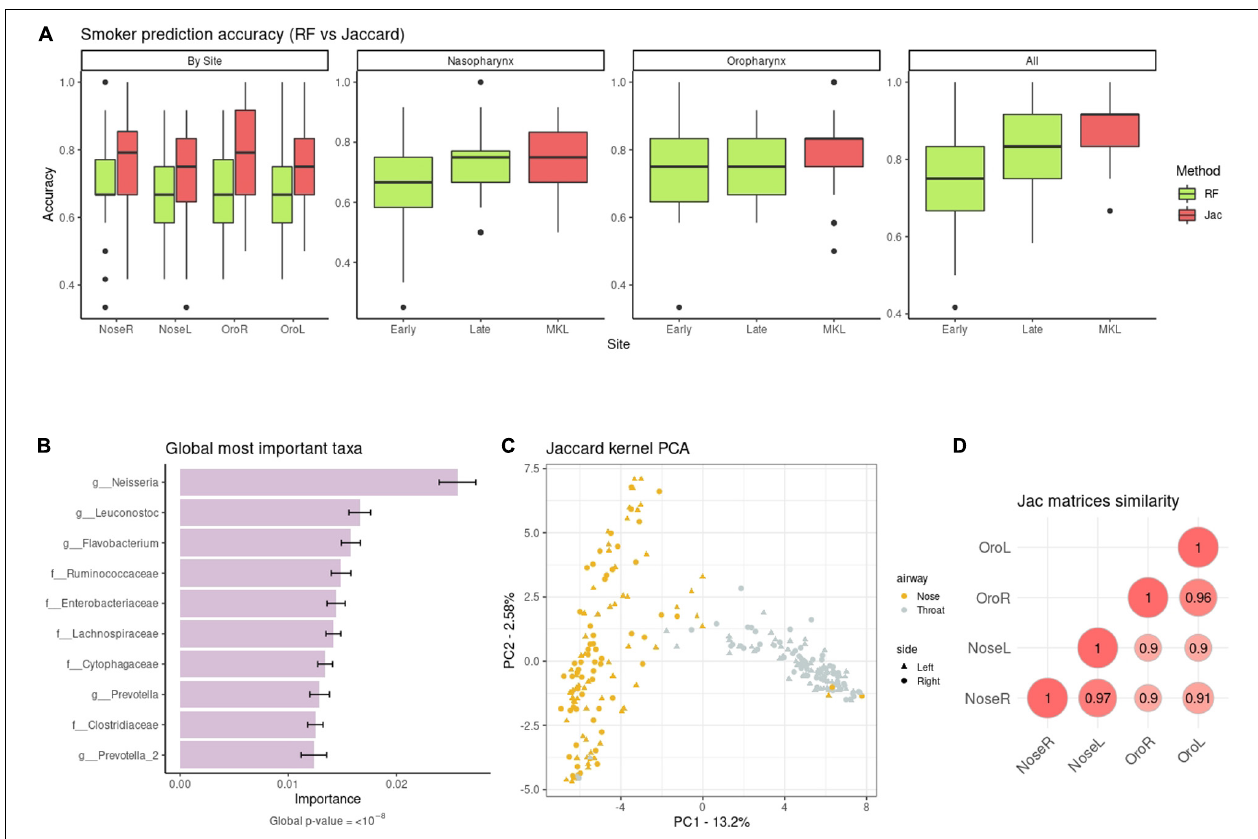
FIGURE 3 | (A) Non-smoker/smoker accuracies from taxonomic data: RF (green) vs. the quantitative Jaccard kernel (red). NoseL, NoseR, OroL, and OroR models are obtained from single datasets, the Nasopharynx and Oropharynx panels contain the information from the right and left sides, and All the combination of the four datasets. Early and Late refer to the early integration and late integration approaches for RF. (B) Top ten global cLin-SVM importances across all body sites. (C) Similarity across the Jaccard kernel matrices of the four sites (Nasopharynx Right and Left and Oropharynx Right and Left). (D) Jaccard kPCA of the taxonomic abundances. Color code represent airway site, whereas shape indicates the laterality of the